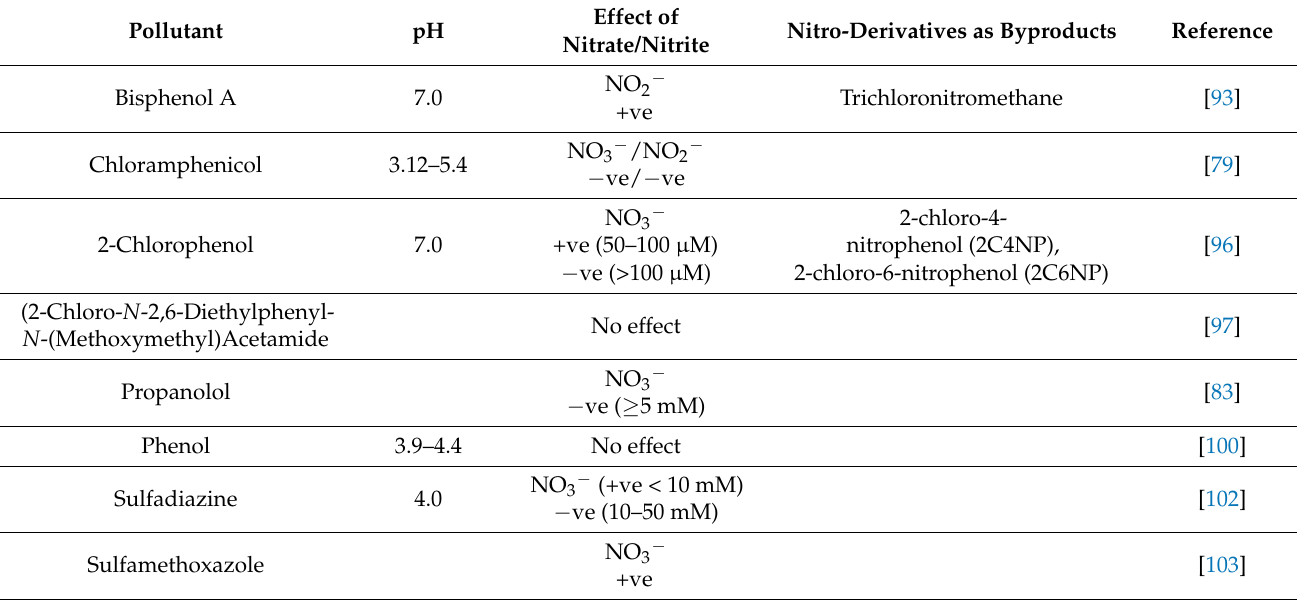
Table 3. Effect of nitrite/nitrate ion over pollutant